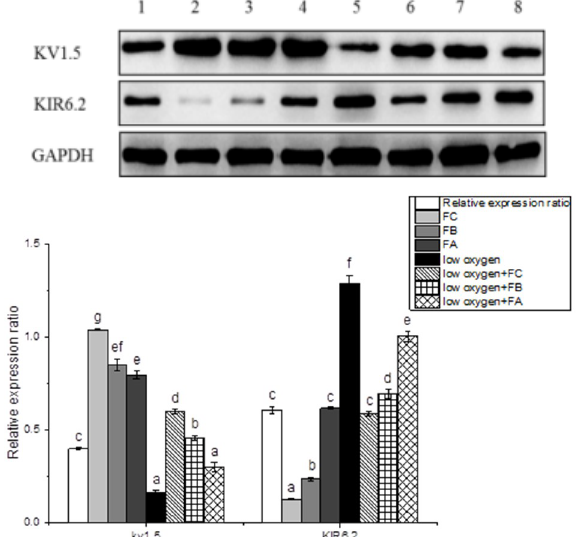
Figure 7. The effect of three fractions A, B and C on the expressions of KV1.5 and KIR6.2 under hypoxia with 2% oxygen content. Western blot analysis was implemented to present the expression of proteins. Densitometry analysis was employed to analyze the densities of brands. Data are presented after normalization by GAPDH. PASM cells were treated by FA, FB, FC (200 µ M) for 24 h. All results were expressed in the form of means ± SD (n= 3). 1: control group under normal oxygen; 2: Fraction A group under normal oxygen; 3: Fraction B under normal oxygen; 4: Fraction C group under normal oxygen; 5: control group under hypoxia; 6: Fraction A group under hypoxia; 7: Fraction B group under hypoxia; 8: Fraction C group under hypoxia.